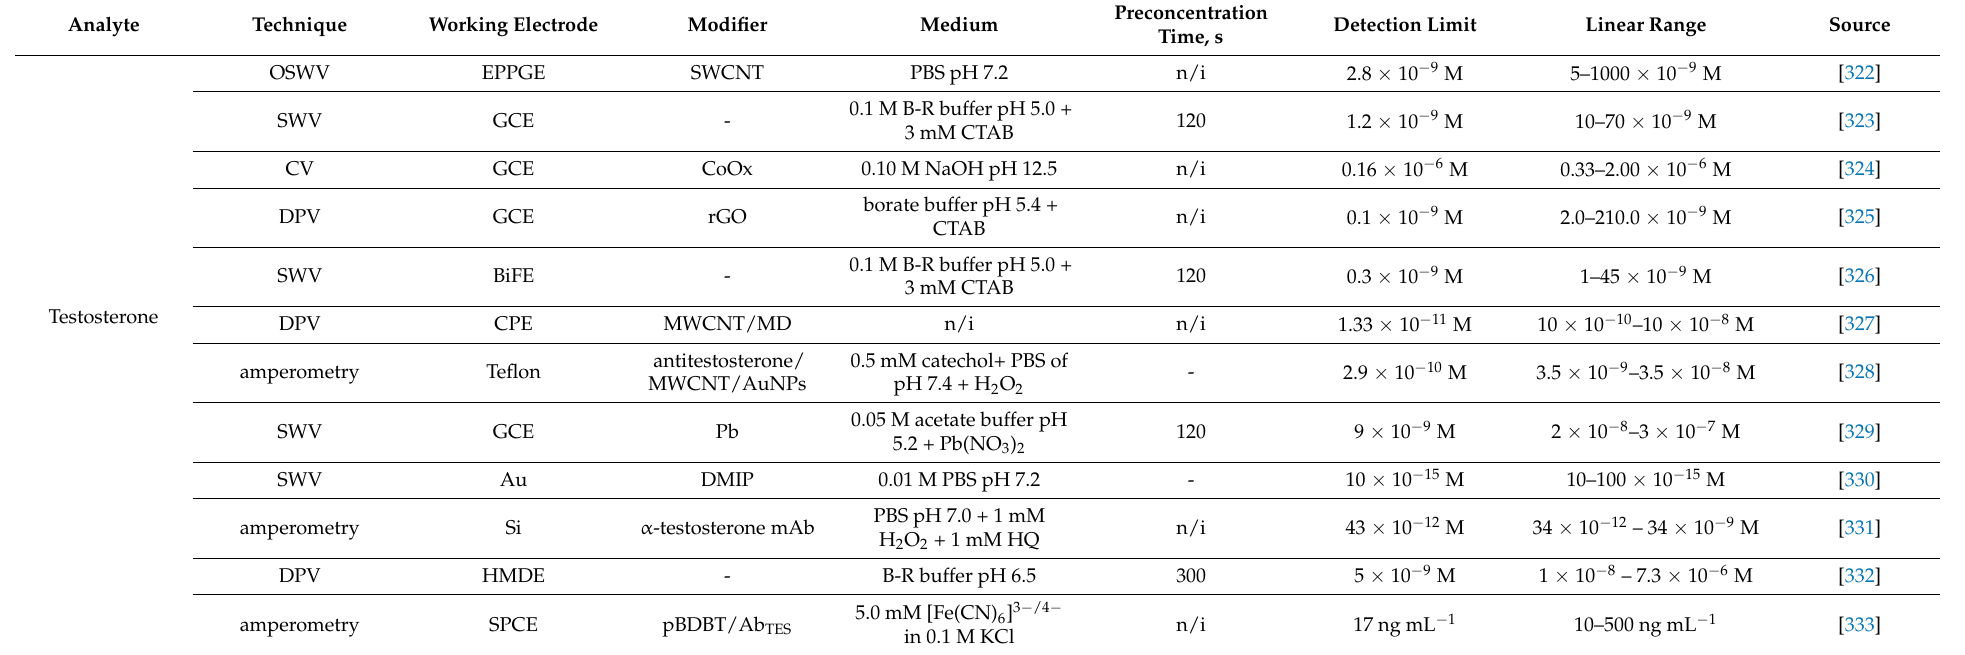
Table 6. Electrochemical methods of testicular hormones